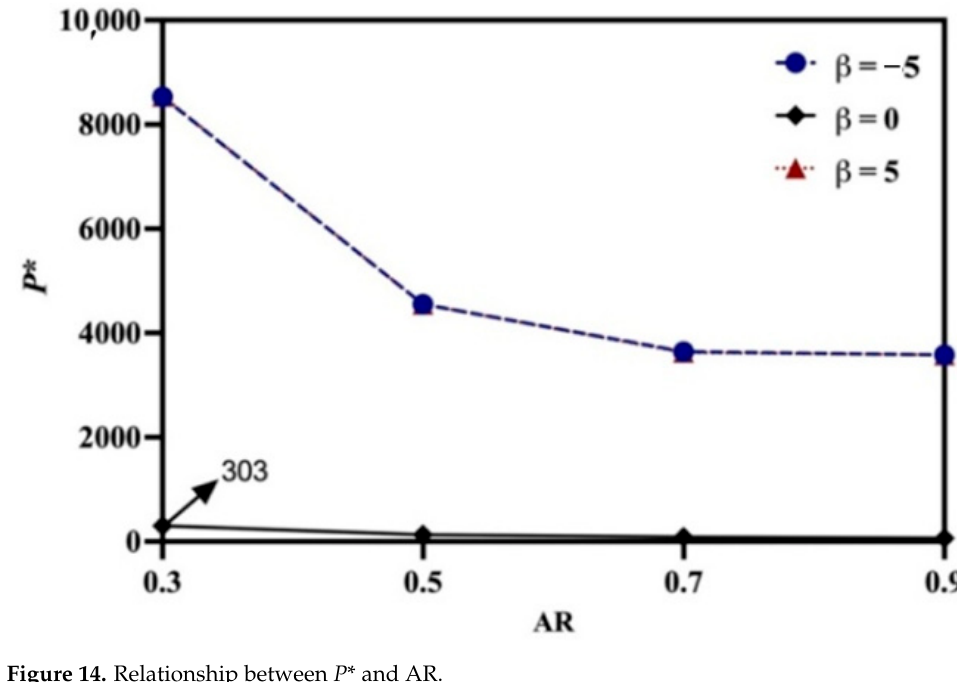
Figure 14. Relationship between P * and AR.